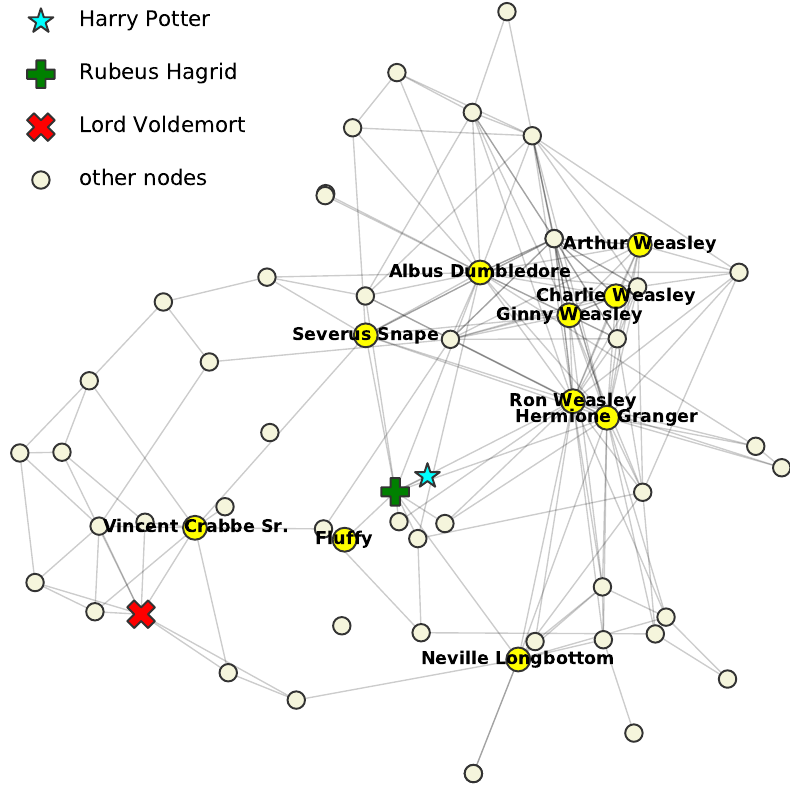
Figure 3. Harry Potter network with suggestions from Table 3 highlighted. Table 3. Top 5 query selections for the other three strategies of ALPINE. Strategy Page-Rank.